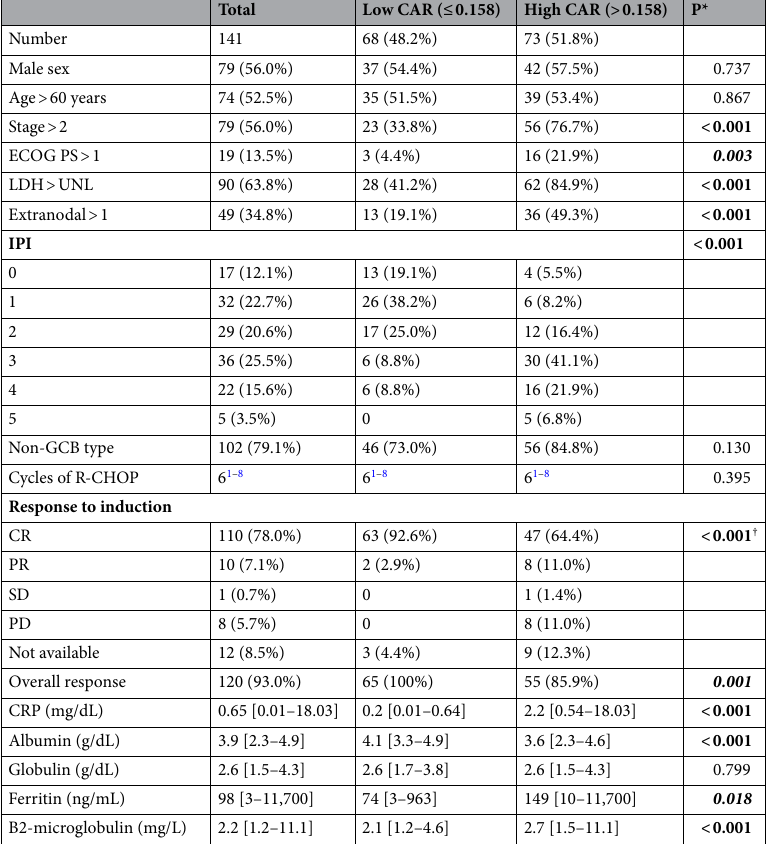
Table 1. Clinical characteristics of patients with diffuse large B-cell lymphoma. Data are presented as number of patients (frequency) for categorical variables and as median [range] for continuous variables. CAR C-reactive protein-to-albumin ratio, ECOG PS Eastern Cooperative Oncology Group performance status, LDH lactate dehydrogenase, UNL upper normal limit, IPI International Prognostic Index, GCB germinal centre B-cell, R-CHOP rituximab, cyclophosphamide, doxorubicin, vincristine, and prednisone, CR complete response, PR partial response, SD stable disease, PD progressive disease. *High-CAR group vs. low-CAR group. † CR vs.